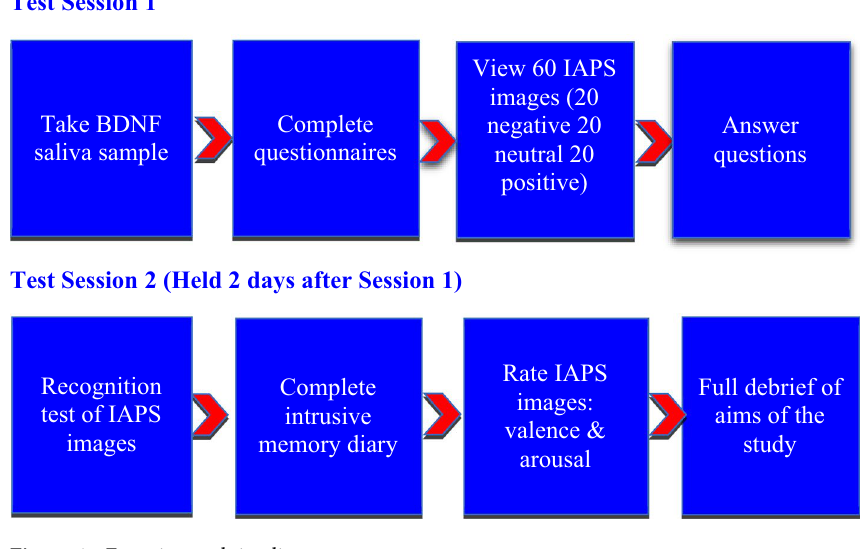
Figure 4. Experimental